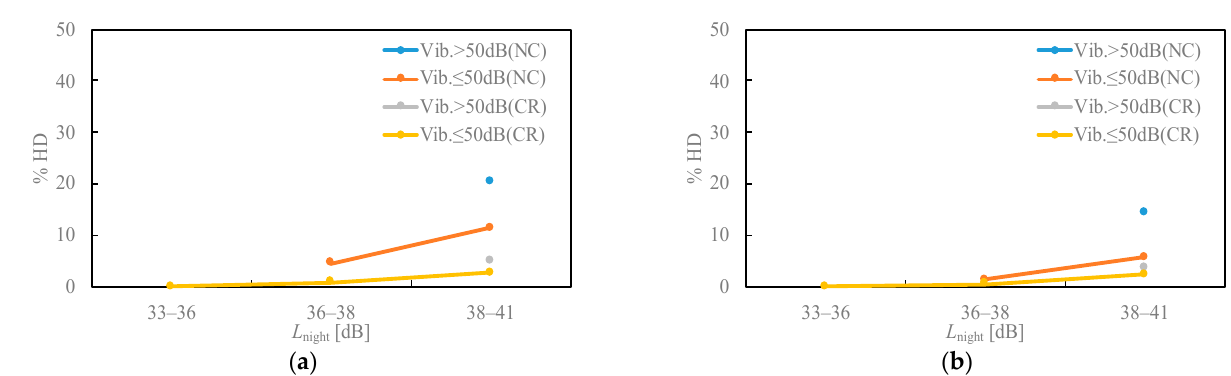
( b ) Figure 3. Relationships between noise exposure level and HA. ( a ) L ASmax ; ( b ) L den . Figure 4 displays the relationship between the falling asleep disturbance and awak- ening. The falling asleep disturbance in the NC area was high, in the range of 38–41 dB L night . In addition, the response to a vibration level of over 50 dB was even higher. Regard-